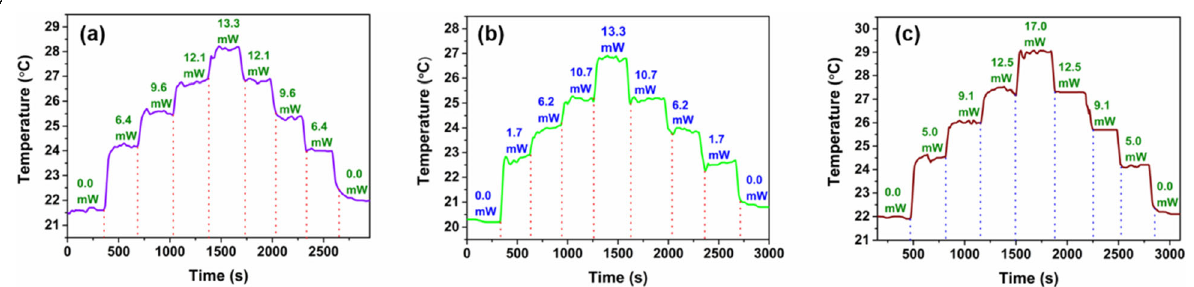
Fig. 9 Temperature of the MF coated with WSe 2 nanosheets for different a violet pump power, b green pump power, and c red pump power